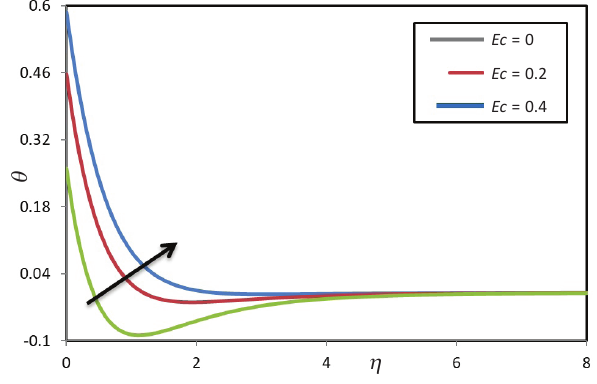
Fig. 4 – θ (temperature) versus h for K = 0.5, I = 0.5, F = –0.5 (heat sink), Pr = 100 (weak polymers), m= 0.3 (general wedge flow) with Eckert number